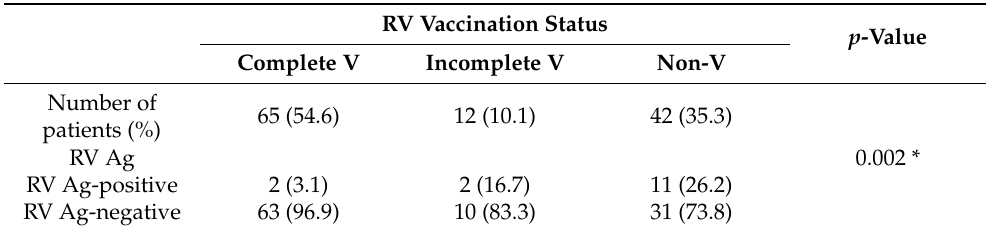
Table 2. Relationship between vaccination history and rotavirus infection in hospitalized children with acute gastroenteritis.